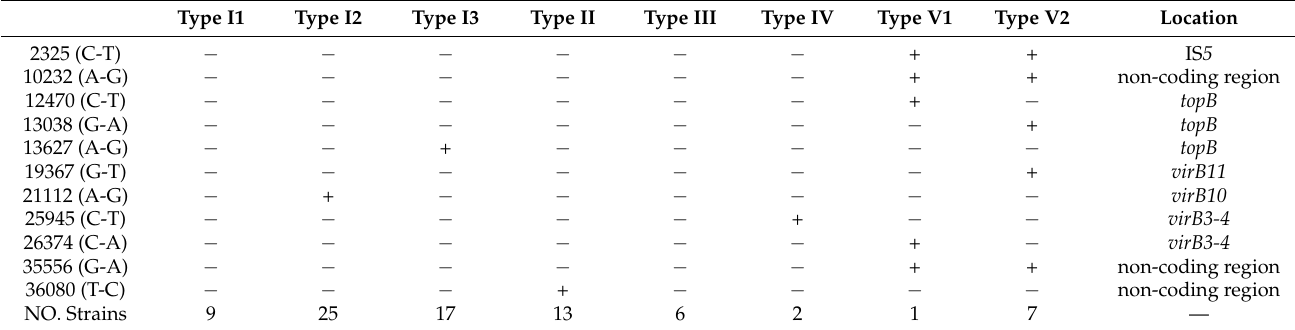
Table 2. Gene mutation sites of blaNDM-IncX3 plasmids